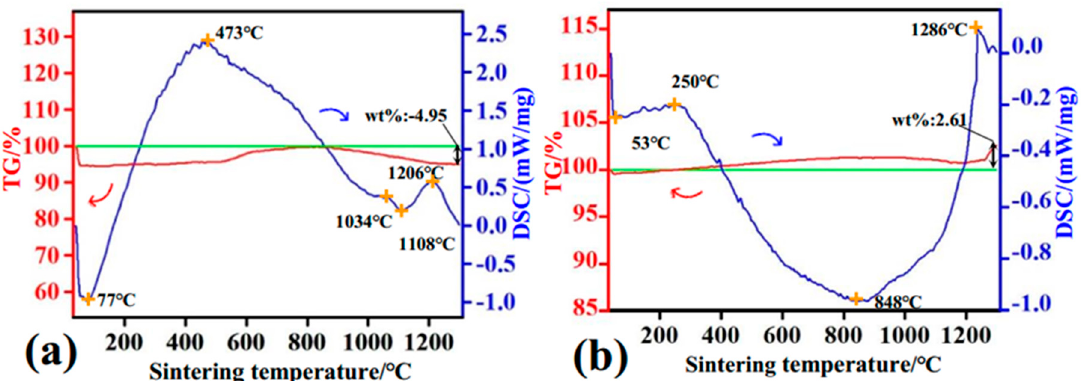
Figure 6. Thermogravimetry–differential scanning calorimetry (TG–DSC) curves of MF/HA composite powders with various MF contents: ( a ) 10 wt%, ( b ) 50 wt%.